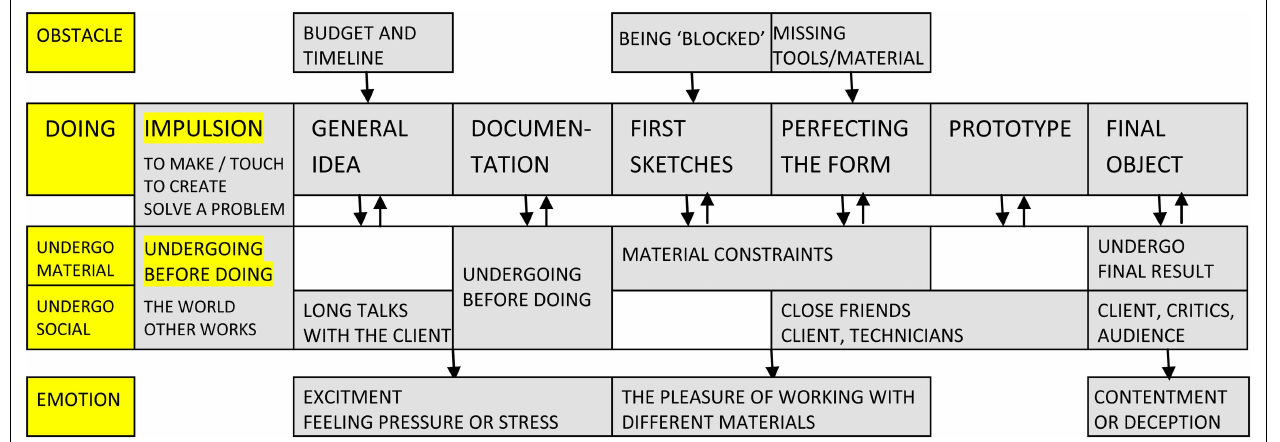
FIGURE 3 | Schematic representation of creative activity in the case of